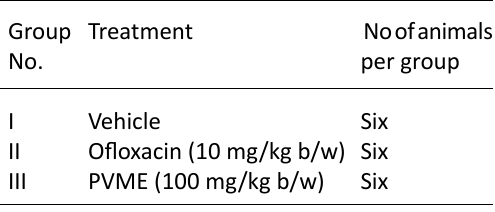
Table 1. Treatment groups for in vivo anti- bacterial study Group